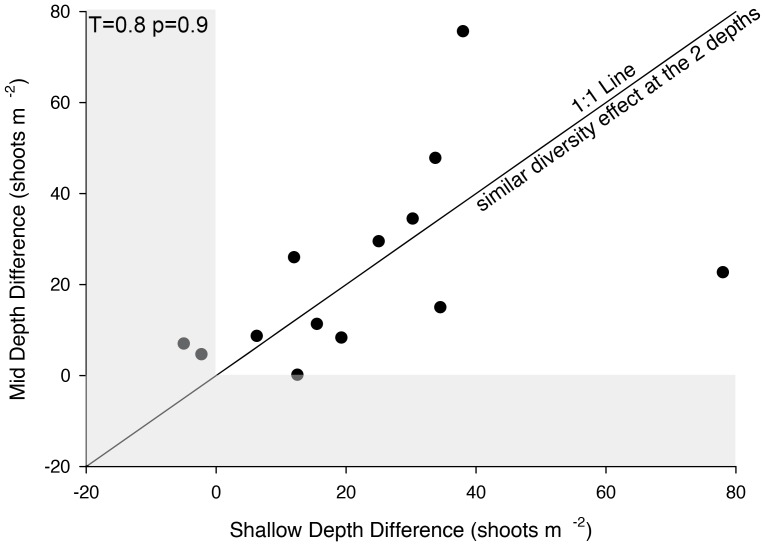
Experimental Zostera marina plots were planted in Hog Island Bay in two levels of genetic diversity: relatively high (4.4 alleles per locus ±0.3 s.e.) and relatively low (3.5 alleles per locus ±0.3 s.e.).Plots were replicated at depth. Plots at a depth less than 1 m were apparently heat stressed had reduced densities, while plots at depths between 1 and 1.4 m had high densities that increased over time. For each sampling date, a difference in density between high diversity and low diversity plots was calculated at each depth. A paired t-test (paired at sampling date) was used to determine if there was a greater effect of diversity on density at the different stress levels. The solid line is a 1∶1 line representing no differences in the effect of diversity between the two depths. The grey areas represent samples where the effect of genetic diversity on plant density was not significant.